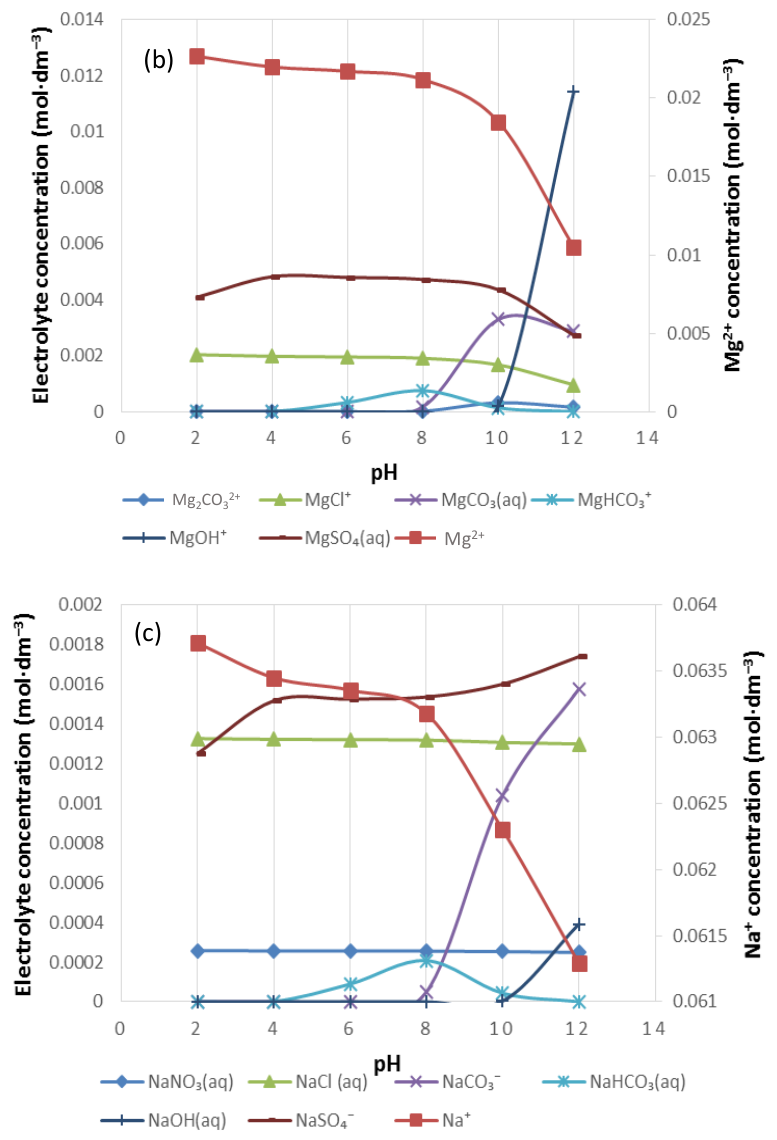
Figure 12. The speciation of ( a ) Ca 2+ , ( b ) Mg 2+ and ( c ) Na + in 10SPW.